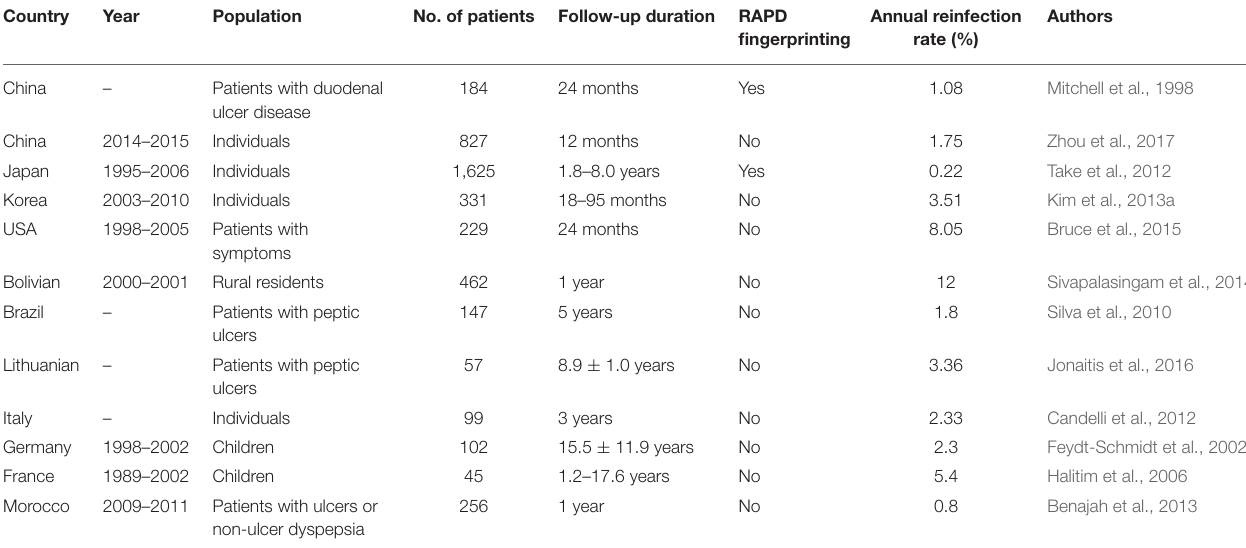
TABLE 1 | Helicobacter pylori reinfection rates in individuals worldwide.